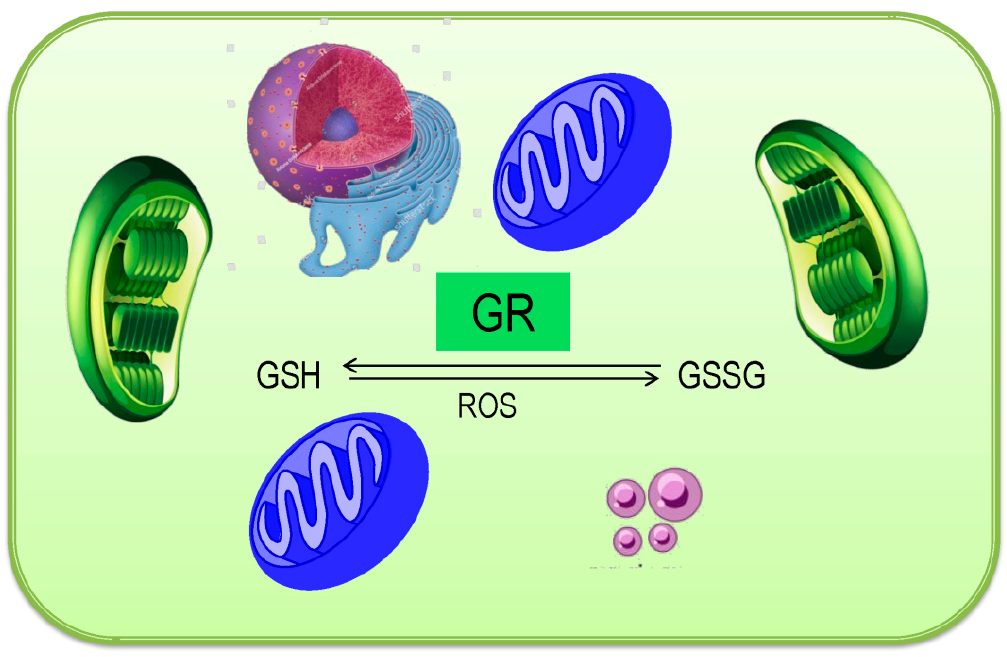
Figure 7. Mechanistic scheme for the enzymatic reduction of glutathione/oxidized glutathione (GSSG) in a plant cell.